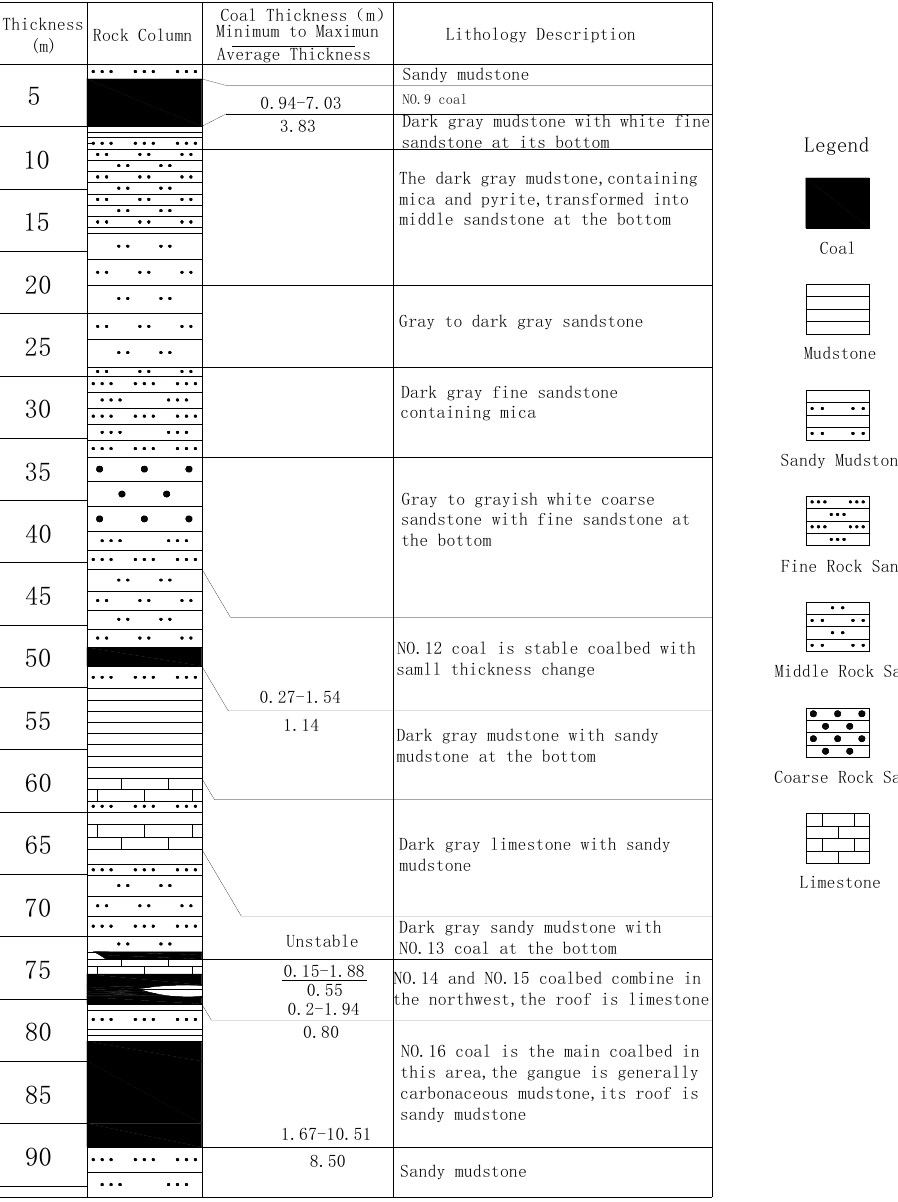
Figure 5. The coal-bearing sedimentary sequence from Gongwusu mine.